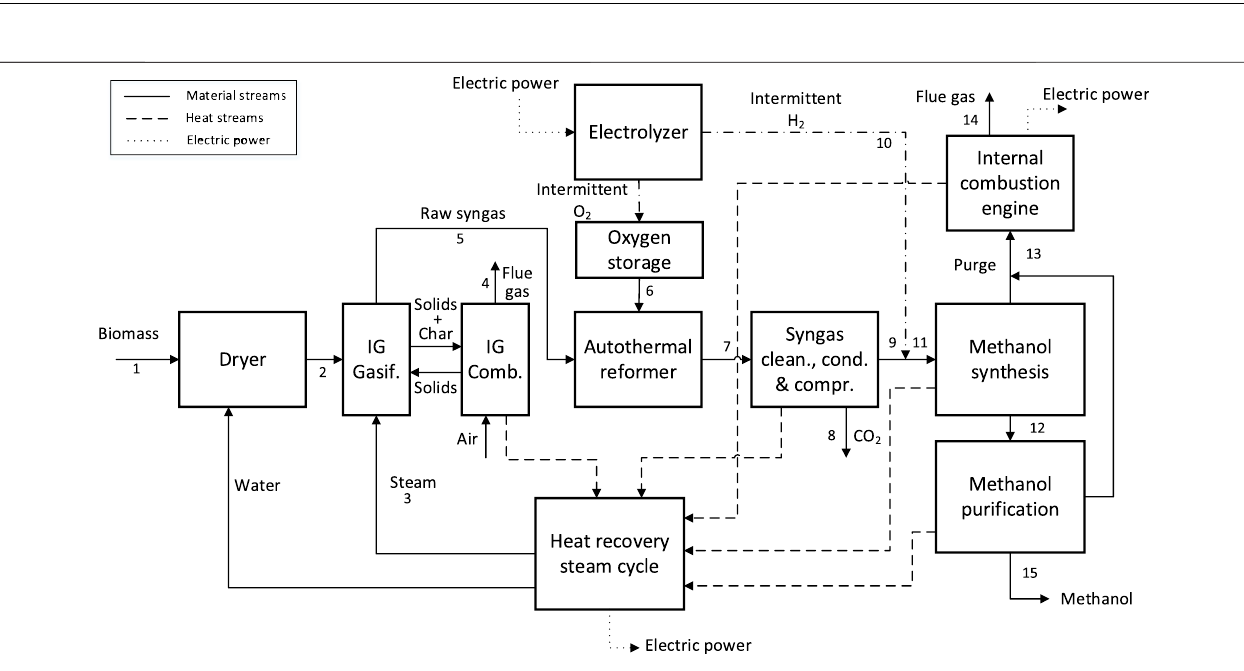
FIGURE 2 | Block diagram of the IG-based power and biomass-to-methanol